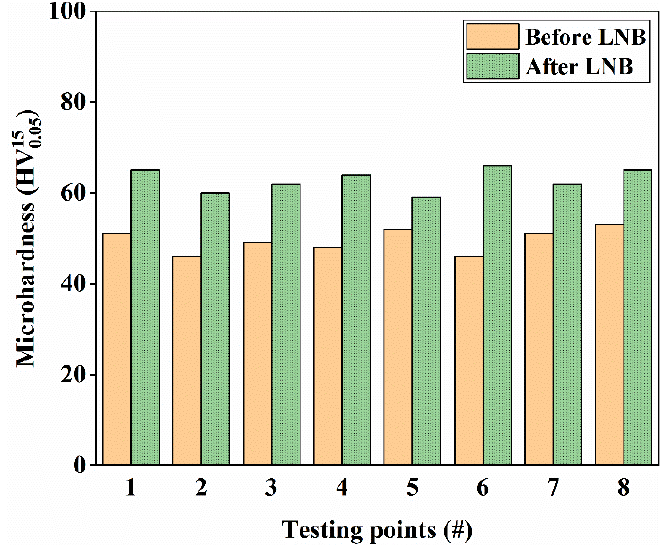
Figure 7. Microhardness of AZ31B before and after LNB.